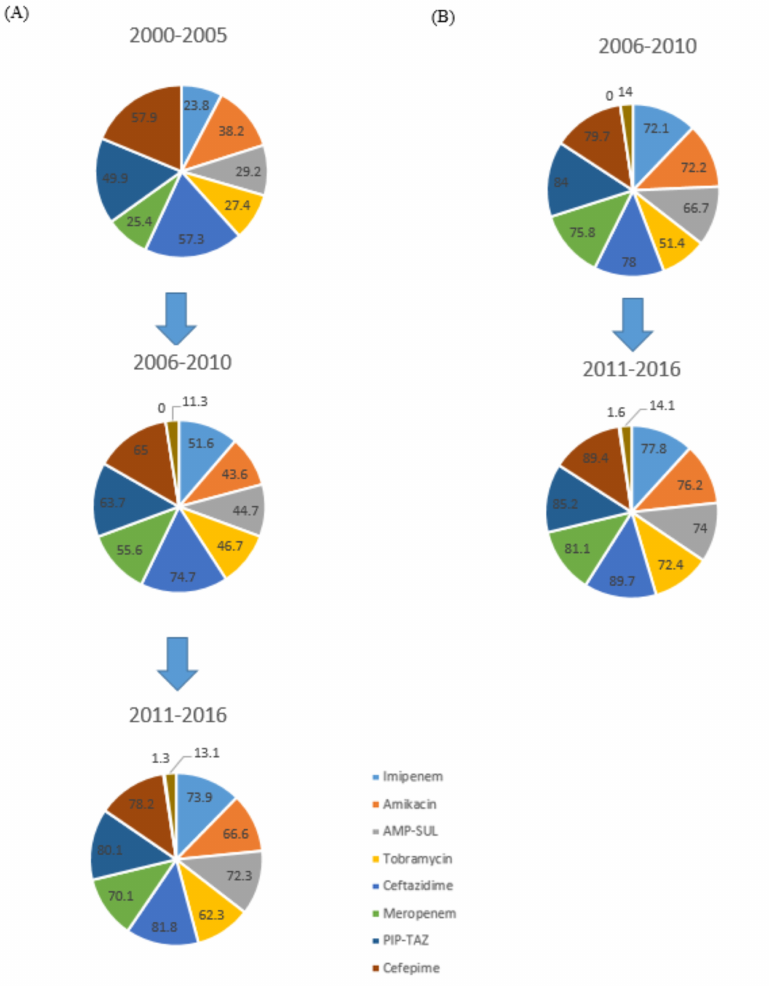
Figure 2. Resistance of A. baumannii strains in the world to available antibiotics in countries belonging to the Organization for Economic Co-operation and Development (OECD) ( A ) and non-OECD ( B ). PIP-TAZ piperacillin-tazobactam, AMP-SUL ampicillin-sulbactam